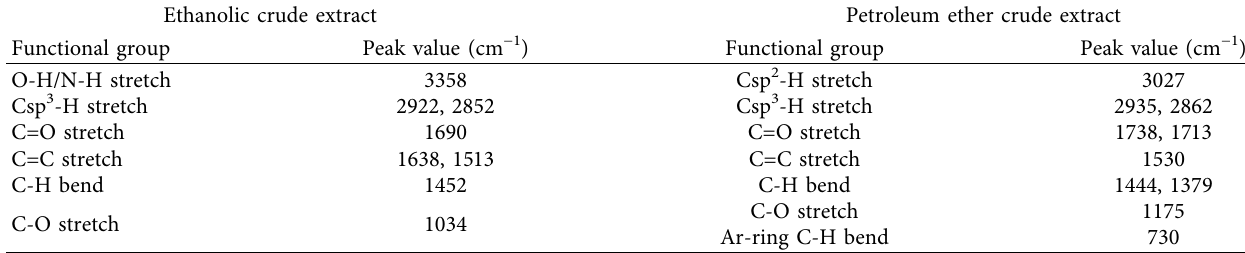
Table 11: FTIR interpretation of the extracts of C. nioroense.